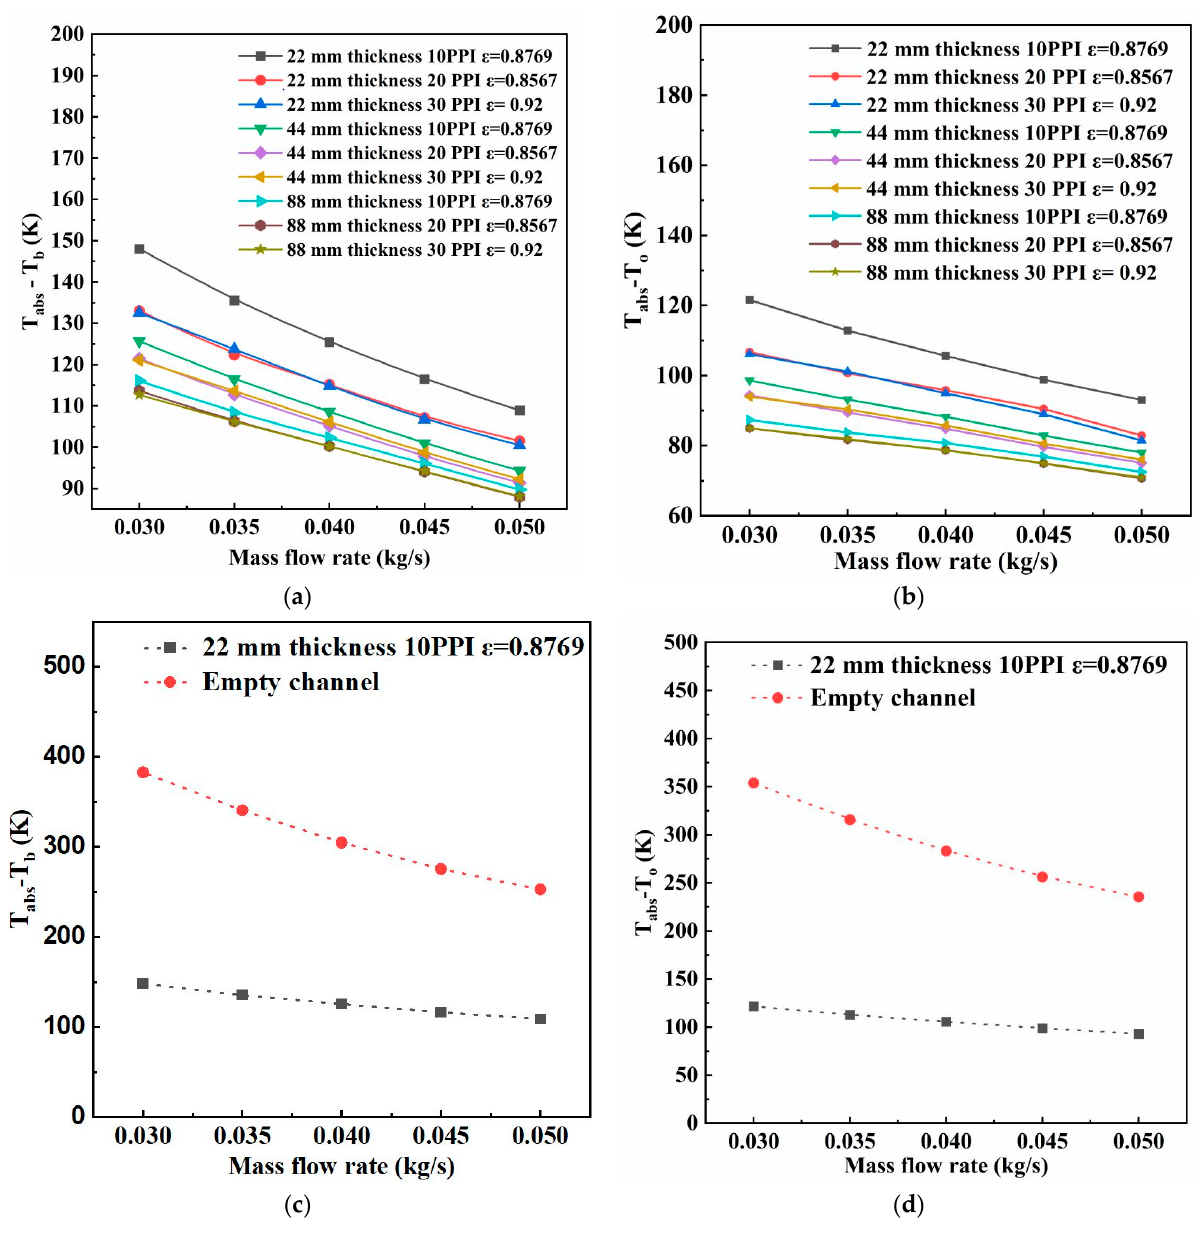
Figure 9. ( a ) Variation of temperature between absorber plate and bulk mean fluid temperature vs. mass flow rate. ( b ) Variation of temperature between absorber plate and outlet temperature vs. mass flow rate. ( c ) Variation of a temperature difference between absorber plate and bulk fluid temperature for empty channel and 22 mm thickness 10 PPI 0.8769 porosity. ( d ) Variation of the temperature difference between absorber plate and outlet temperature for empty channel and 22 mm thickness 10 PPI 0.8769 porosity.